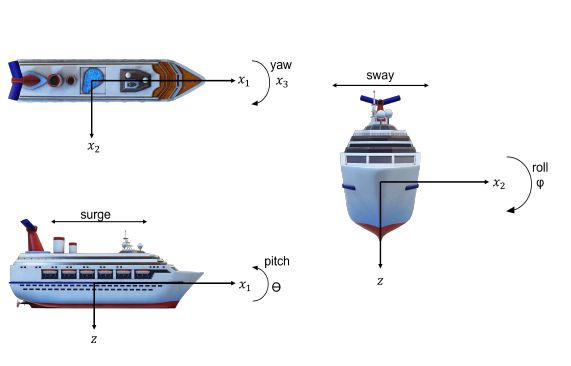
Figure 2: The figure is illustrating the 3 degrees of free- dom of a vessel. For DP systems we are in- terested in controlling 3 degrees of freedom, surge, sway and yaw. The figure illustrates motion and rotation variables for a Vessel.